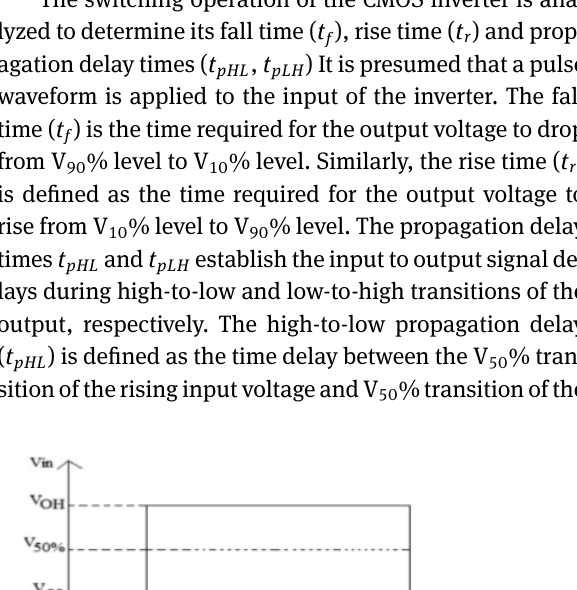
Figure 2. The input and output voltage waveforms of CMOS inverter circuit are shown in Figure 3.